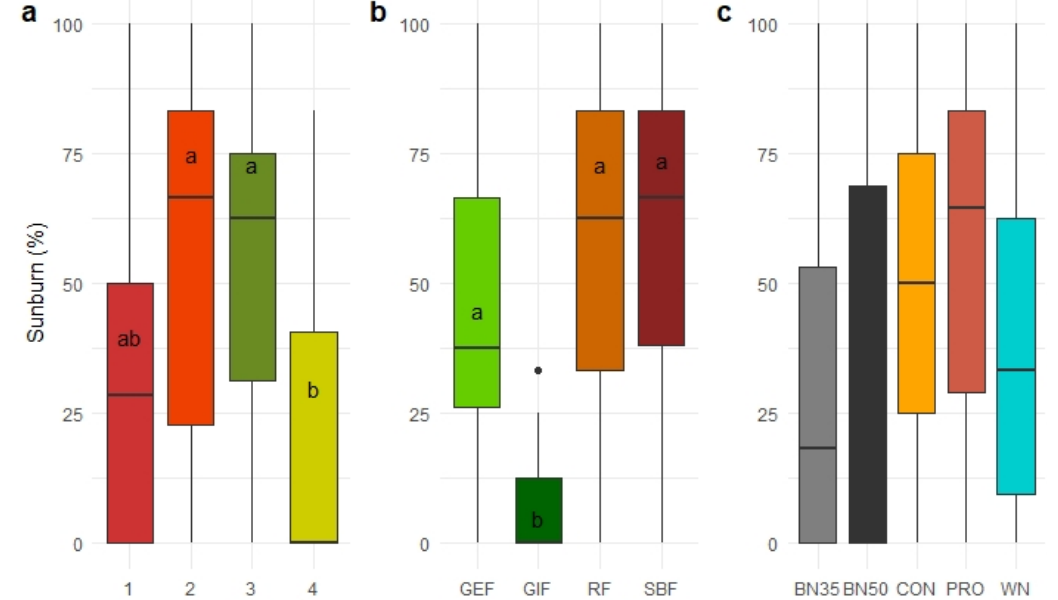
Figure 7. Incidence of final sunburn in evaluated fruits, according to: ( a ). season (1 to 4), ( b ). fruit condition (RF = red fruit, GEF = green external fruit, GIF = green internal fruit, and SBF = sunburned fruit), and ( c ). treatment (BN35 = Black net 35, BN50 = Black net 50, WN = White net, CON = control and PRO = protectants). The box represents interquartile range (IQR); the upper (Q3) and lower (Q1) quartiles are the ends. The line in the box is the median and the whiskers are the range of the data, excluding outliers. Outliers are values higher than Q3 + 1.5 IQR or smaller than Q1 − 1.5 IQR. Boxes with different letters indicate significant differences ( α = 0.05); the absence of letters indicate non-significant differences.